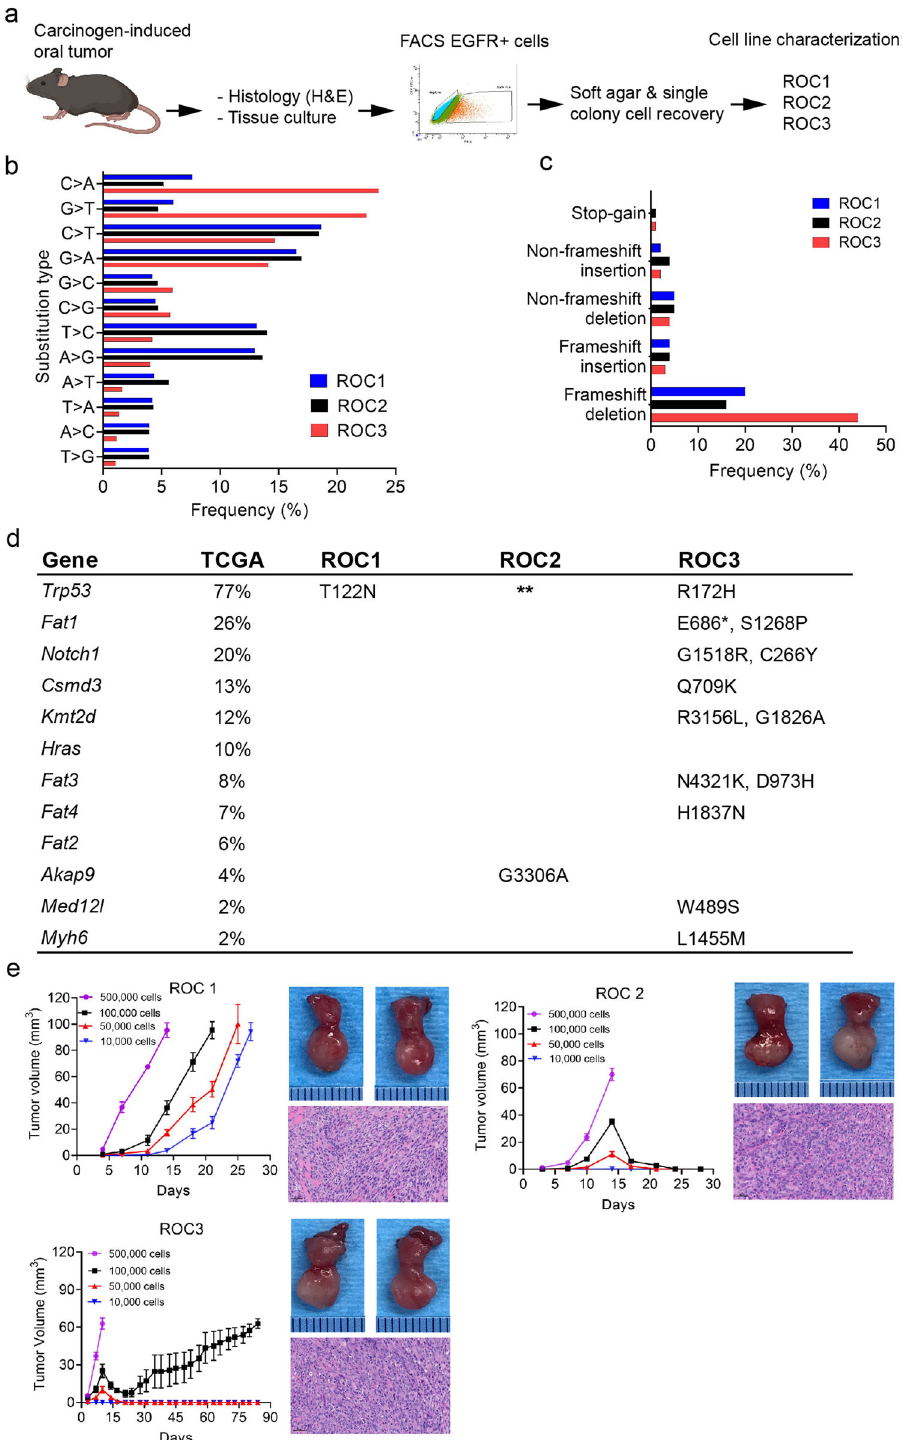
Fig. 1 Mutational landscape and tumorigenesis of syngeneic ROC cell lines derived from a murine model of carcinogen-induced oral cancer. a Strategy for generating syngeneic ROC mouse oral cancer cell lines. b Frequency of somatic substitutions in ROC cell lines. c Frequency of functional INDELs in ROC cell lines. d Comparative analysis among ROC cell lines of the genes most frequently mutated in the TCGA-HNSCC cohort. *p53 nonsense mutation; **p53 deletion. e Tumor growth curves of different numbers of injected ROC1 – 3 cells in the orthotopic tongue model. Mean tumor volume are represented in the graph ( n = 5, error bars = standard error mean). The right panels show the primary tumor in the tongue (top) and a representative hematoxylin and eosin – stained section of the primary tumor (bottom). Scale bars, 50 μ